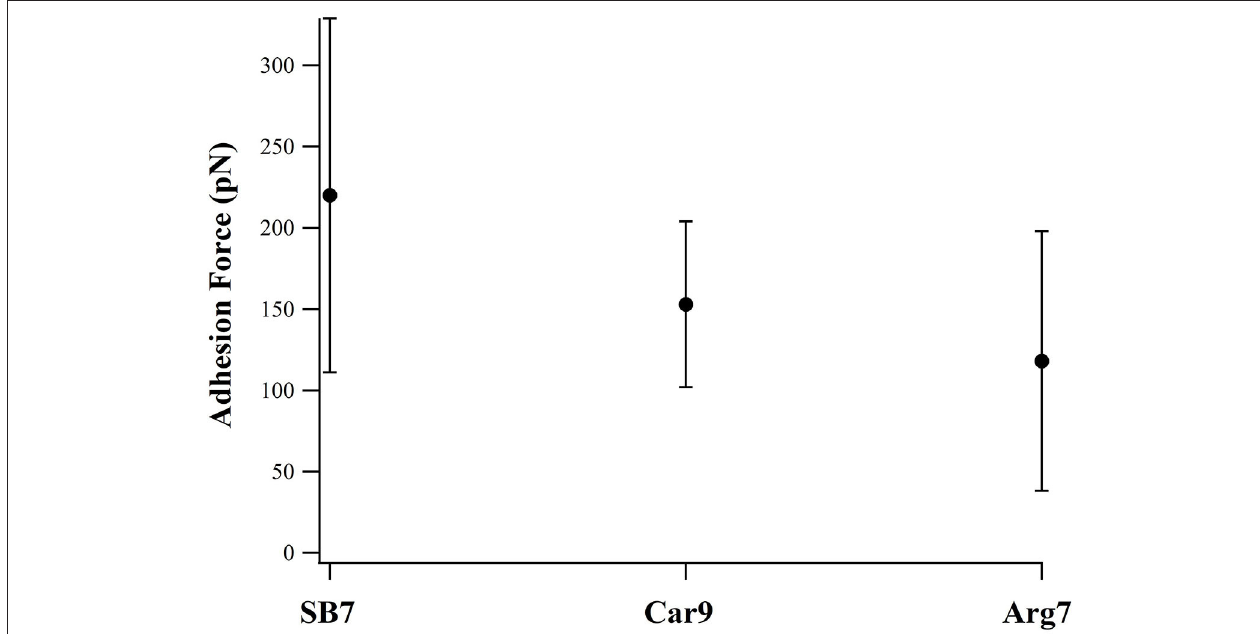
FIGURE 5 | Adhesion forces of SB7, Car9, and Arg7 on glass surface (pulling speed of 10 um/s).